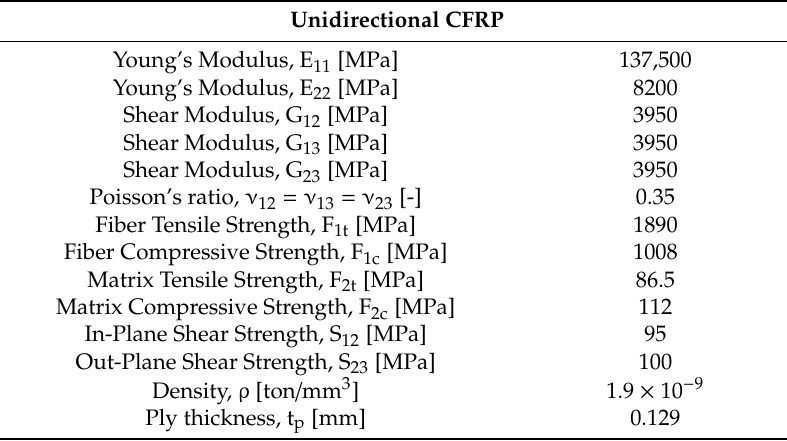
Table 2. Unidirectional fiber composite material mechanical properties.